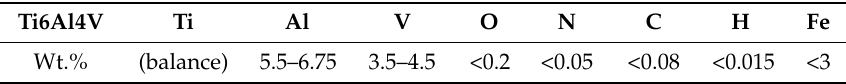
Figure 3. SEM micrographs of the Ti6Al4V powder, ( a ) ×500 and ( b ) ×2000. Table 2. Chemical composition of Ti6Al4V